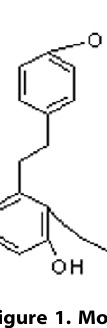
Figure 1. Molecular structure of riccardin D.